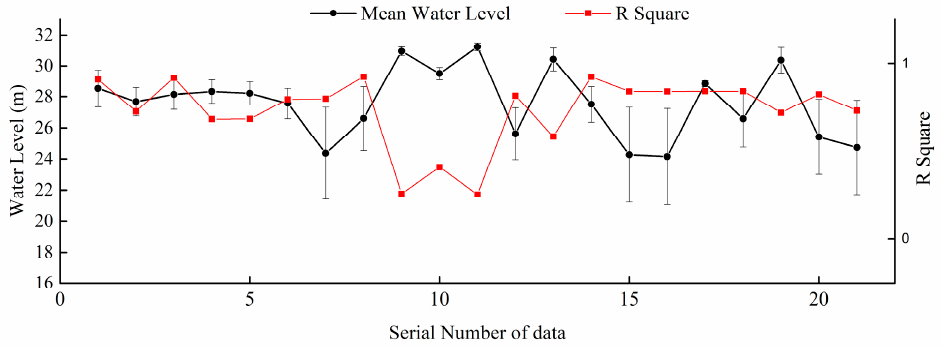
Figure 12. Relationship between water level and correlation coefficient during the study period.